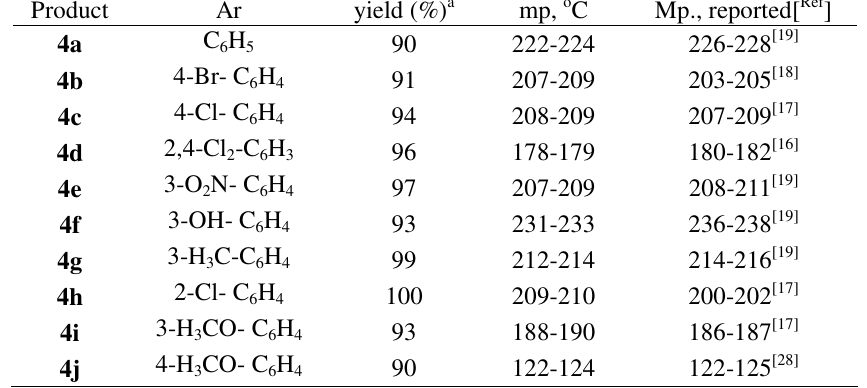
Cl at ambient temperature in water as solvent 2 2